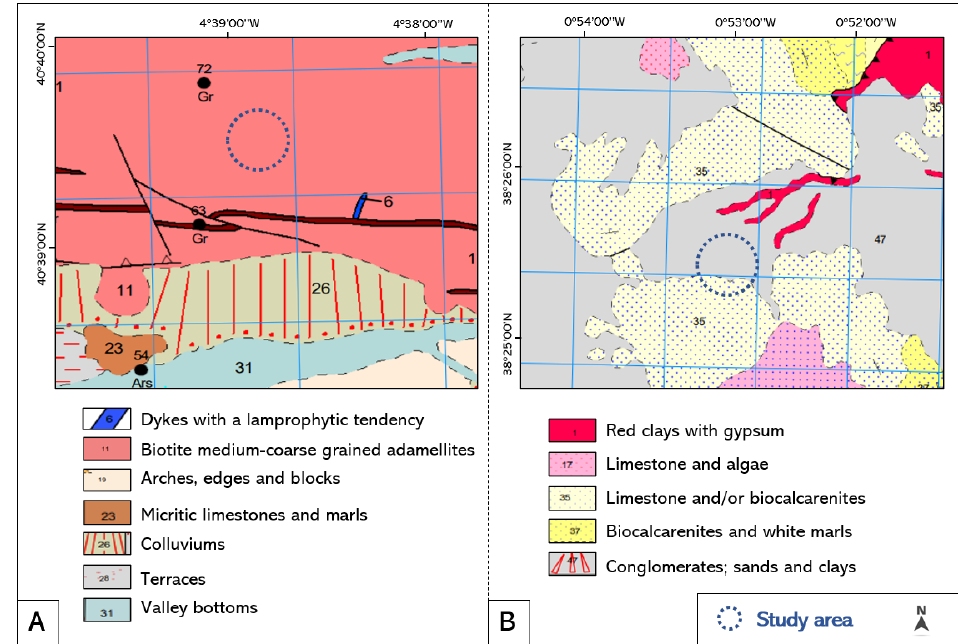
Figure 4. Geology of the areas considered in this research. ( A ) case 1 (Ávila), ( B ) case 2 (Alicante) [36].